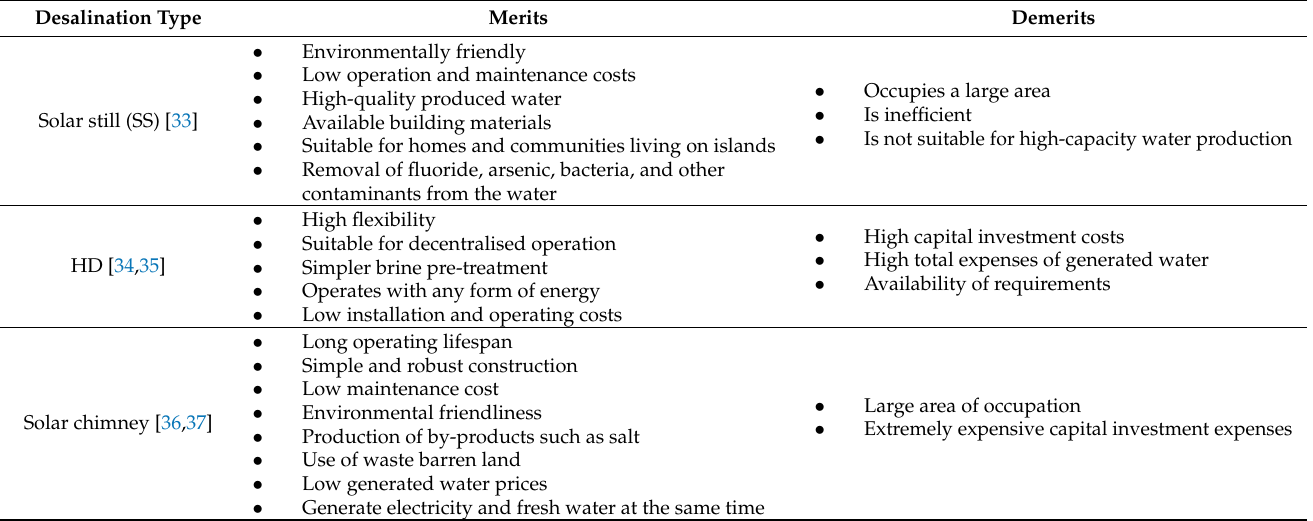
Table 1. Merits and demerits of various solar desalination technologies.